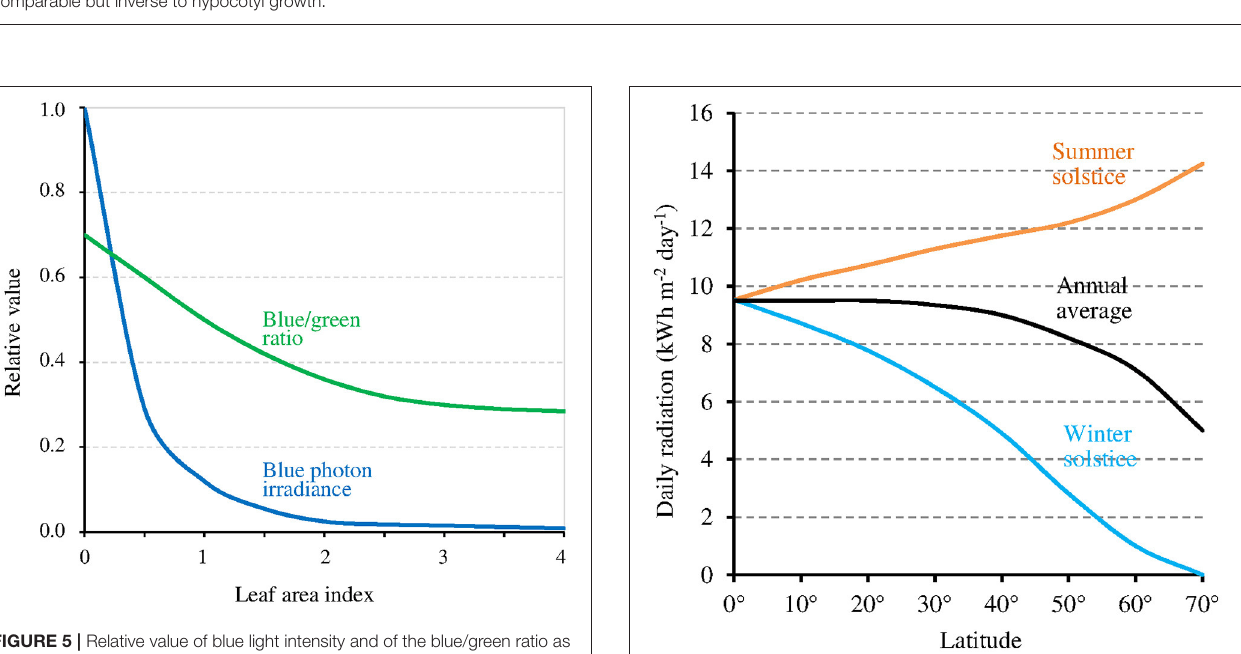
FIGURE 4 | (A) Hypocotyl growth in At Cry 1 according to blue light intensity ( I ), respectively at 22 ◦ and 28 ◦ C (adapted with permission from Ma et al., 2016, © National Academy of Sciences of the United States of America). (B) [Cry*] expressed as its value relative to that at 1 ◦ C, at different temperatures and as a function of I , as evaluated from the present model (this assumes the function k 1 b ( T ) to be linear and is thus only valid at ≤ 20 ◦ C [see text]). [Cry*] varies with I and T in a way comparable but inverse to hypocotyl growth.